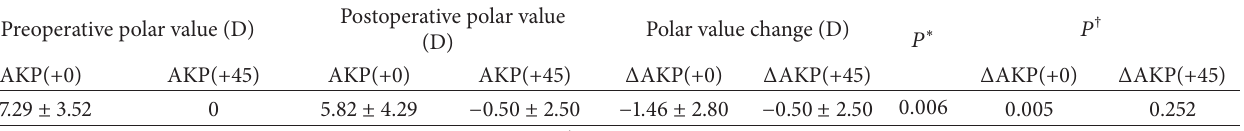
Table 2: Polar value analysis.